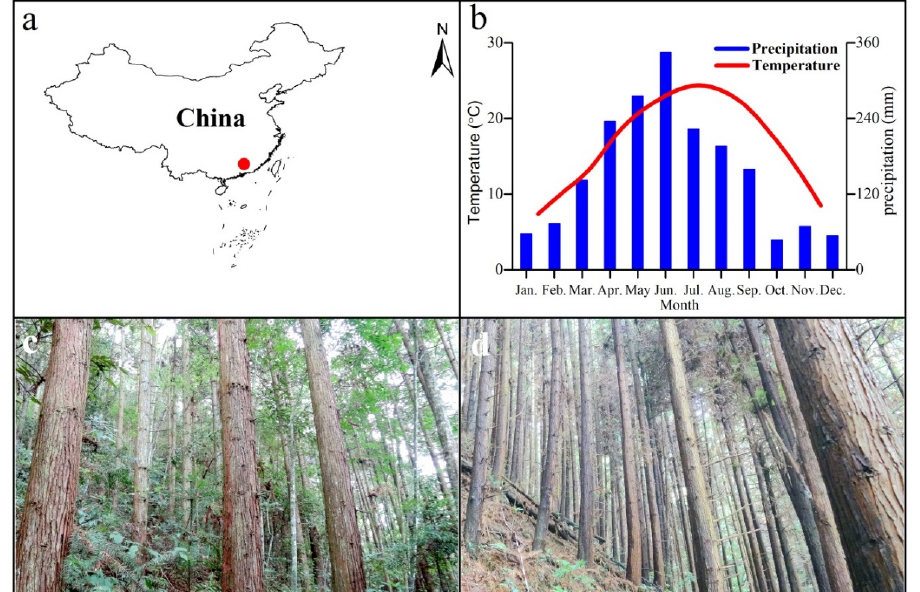
Figure 1. Study region, climate data, and forest structure. ( a ) The sampling site (red) in subtropical China; ( b ) Climate data from the Xiagongtang meteorological station from 2000 to 2014; ( c ) Structure